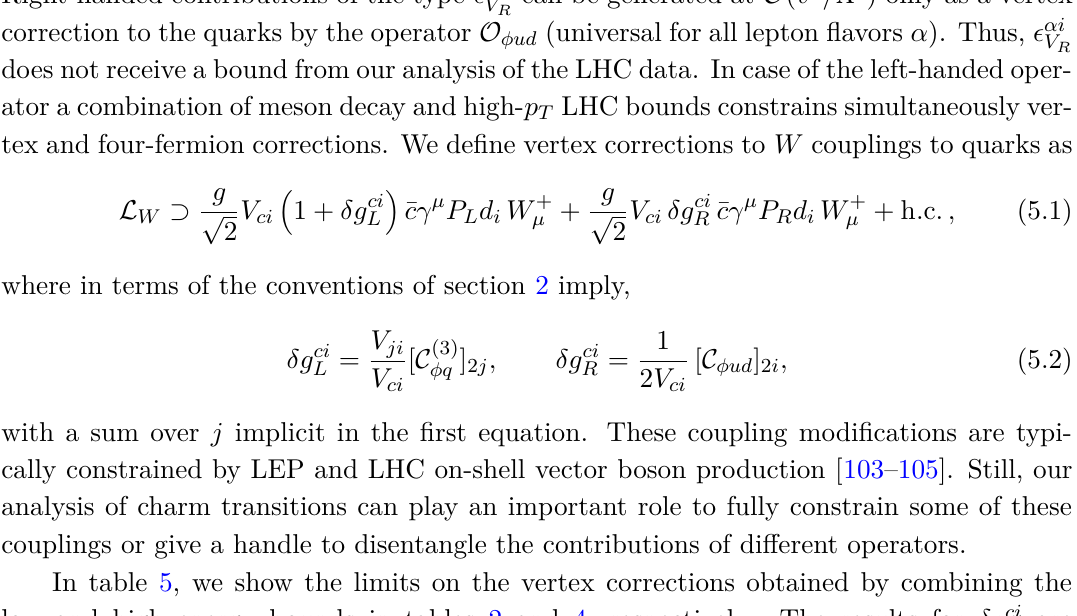
Figure 3 . 95% CL regions for the combined fits of (cid:15) αβi with β = α (red solid line) or β 6 = α (light-red dash-dotted line) and to monolepton LHC data (blue solid line). Projections for the high-luminosity phase of the LHC (3 ab − 1 ), obtained by rescaling the expected limits with luminosity, are represented by dashed